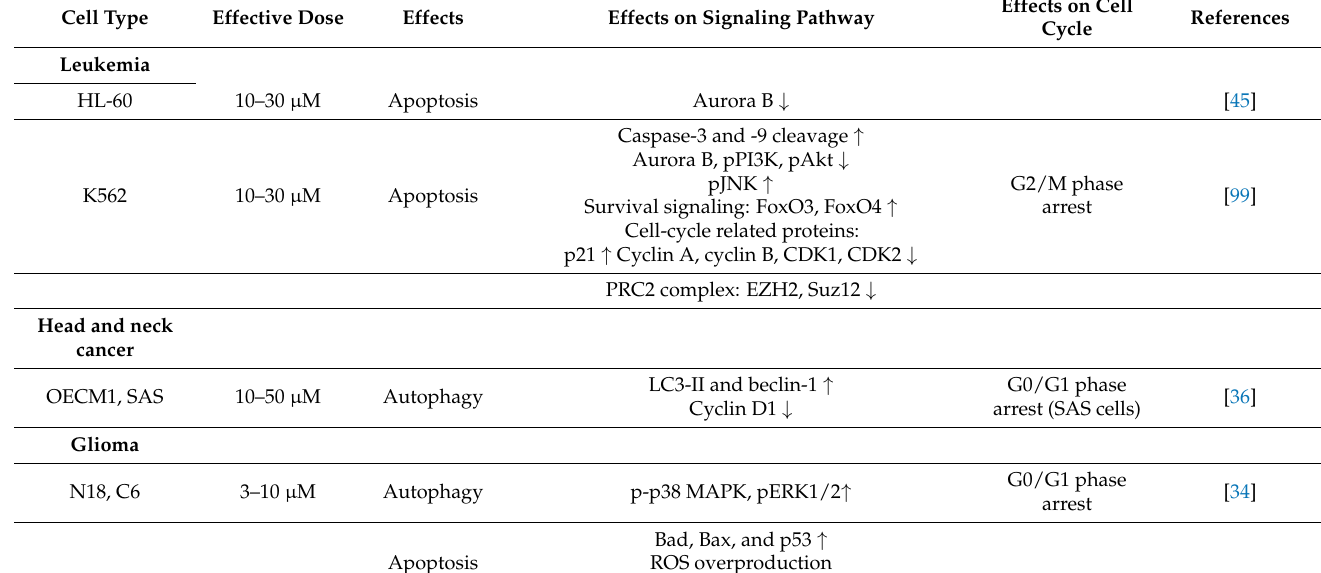
Table 2. Anti-tumor effects of 16-hydroxycleroda, 3,13-dien, and 15,16 olide on different cancer cell